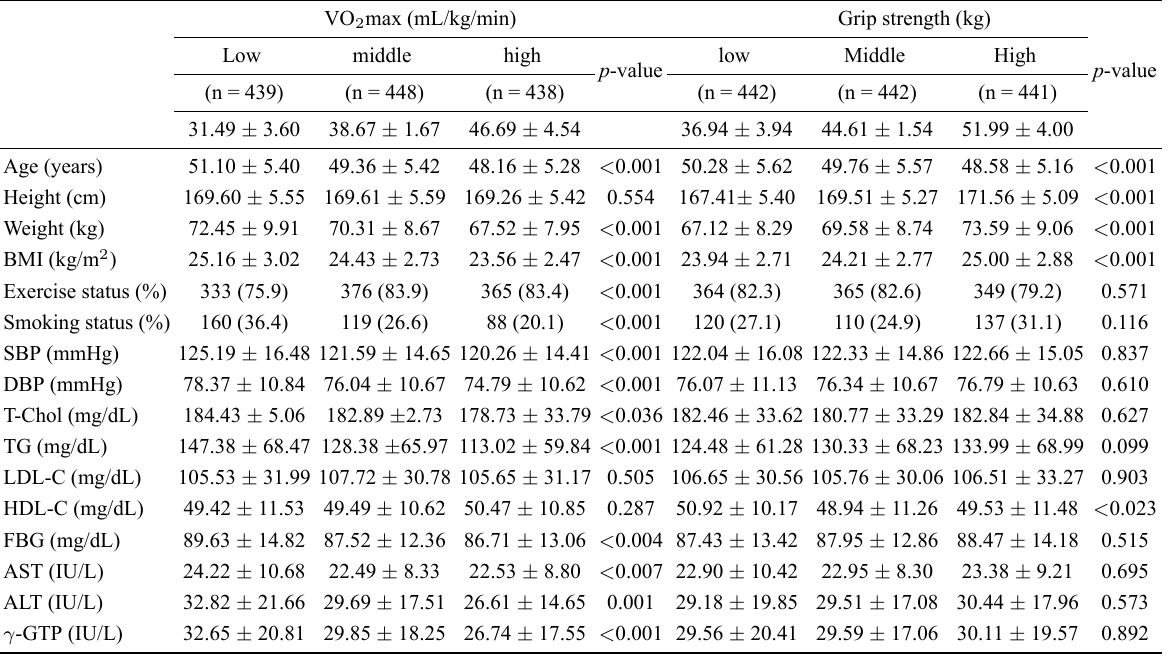
Table 2. Clinical characteristics in accordance with cardiorespiratory fitness level and muscle strength